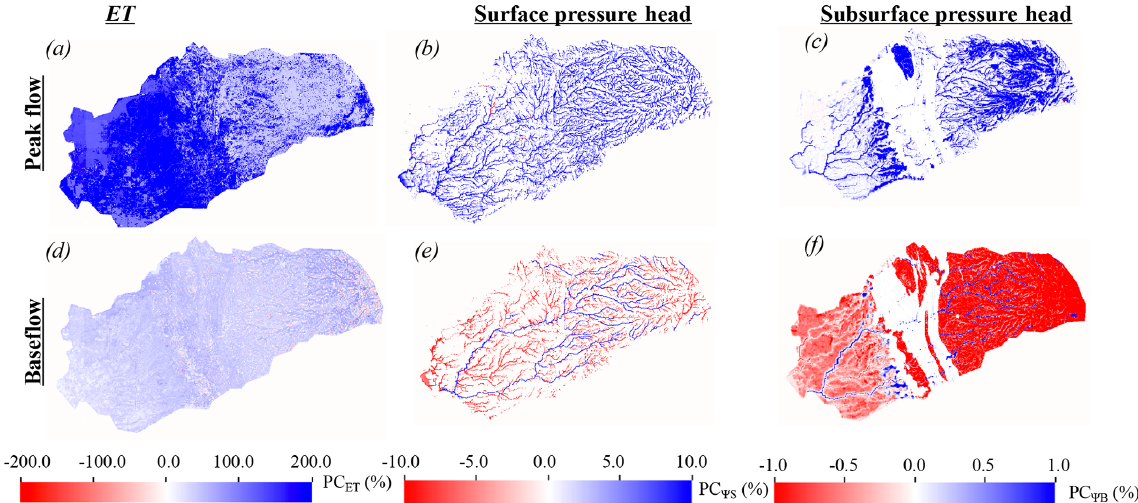
Figure 6. Comparisons between EoC median water year (WY) and the historical median WY peak flow and baseflow spatial distributions of percent changes in ET (PC ET ), surface water (PC (cid:57) S ), and subsurface (PC (cid:57) B ) pressure heads. Regions in red correspond to areas with smaller fluxes or pressure heads in the EoC compared to the historical ones, whereas regions in blue correspond to areas with larger fluxes or pressure heads in the EoC compared to the historical